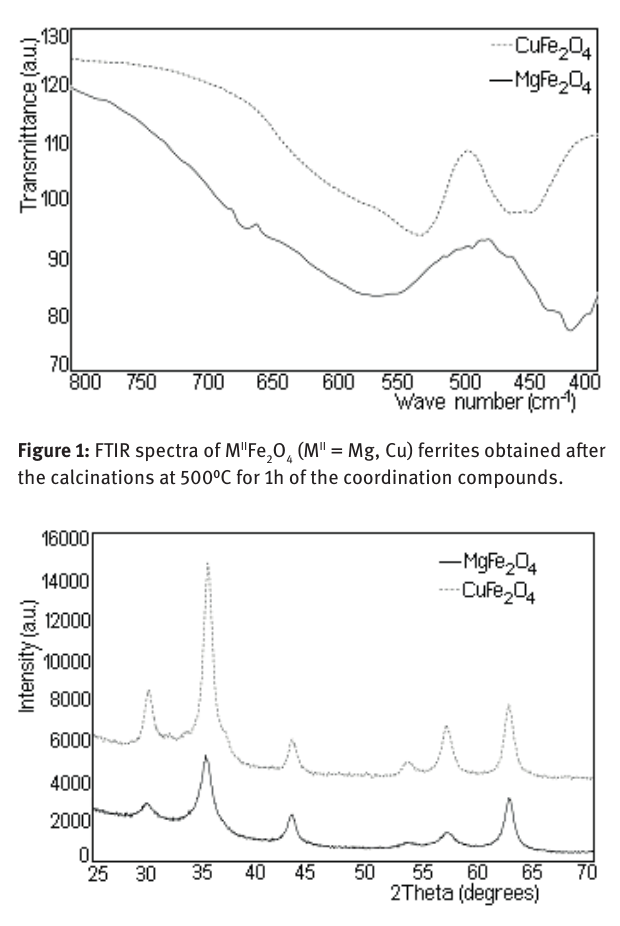
Figure 2: XRD patterns of M II Fe